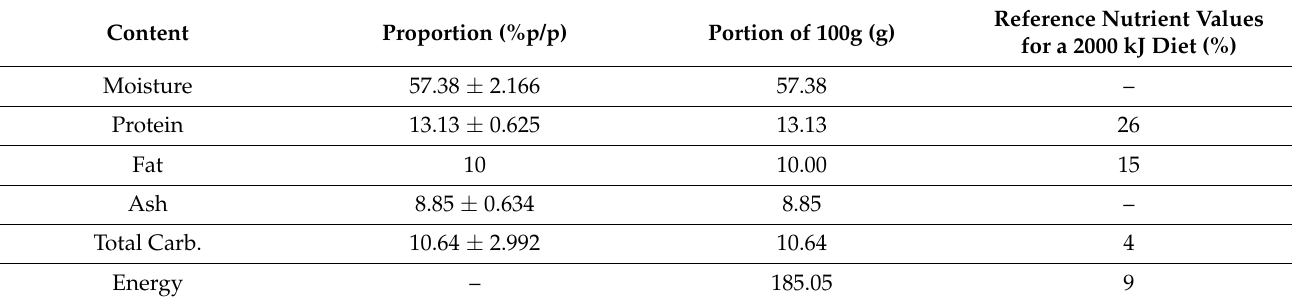
Table 6. Proximal analysis of the fungal burger